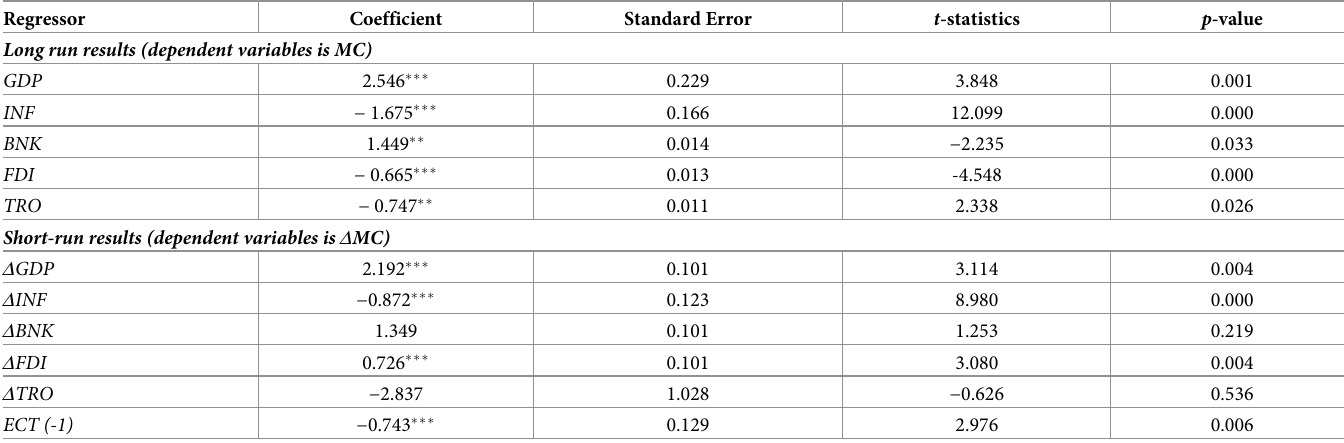
Table 7. The long run and short-run results of the selected